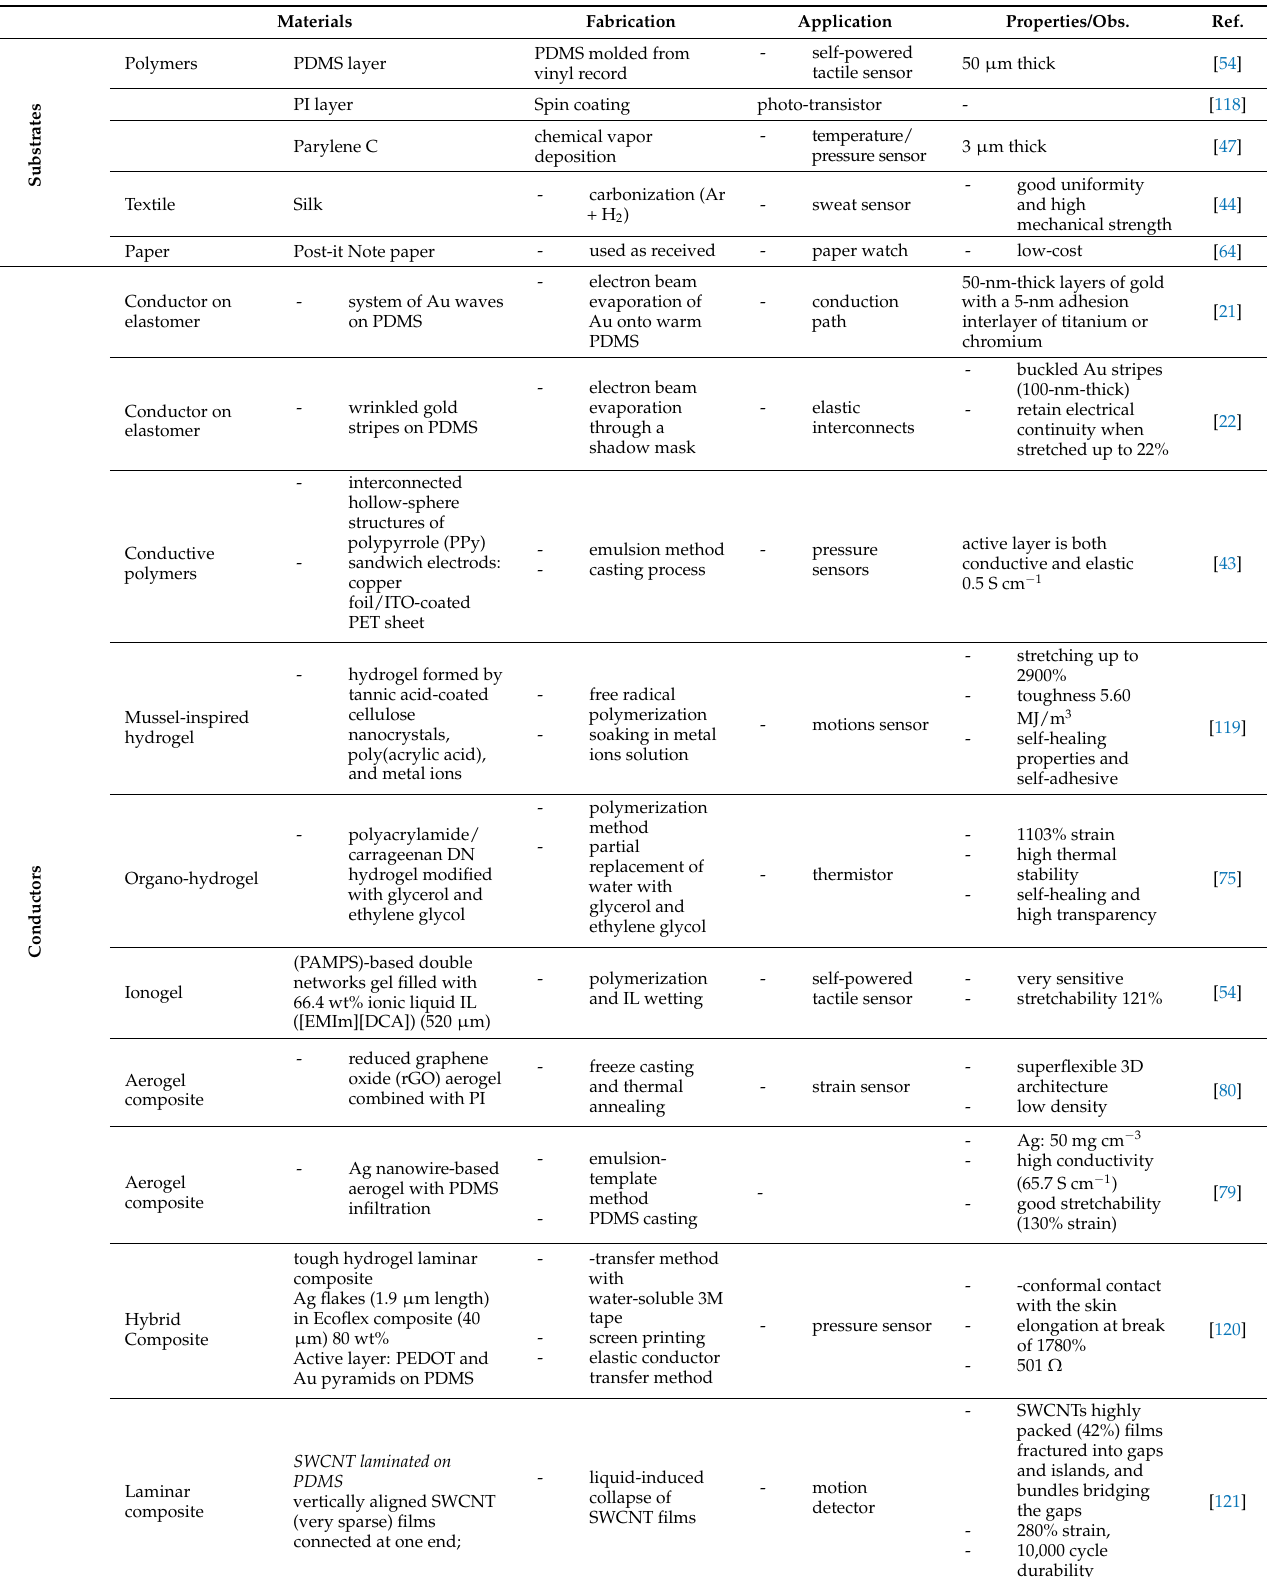
Table 1. Example of the materials used for e-skin